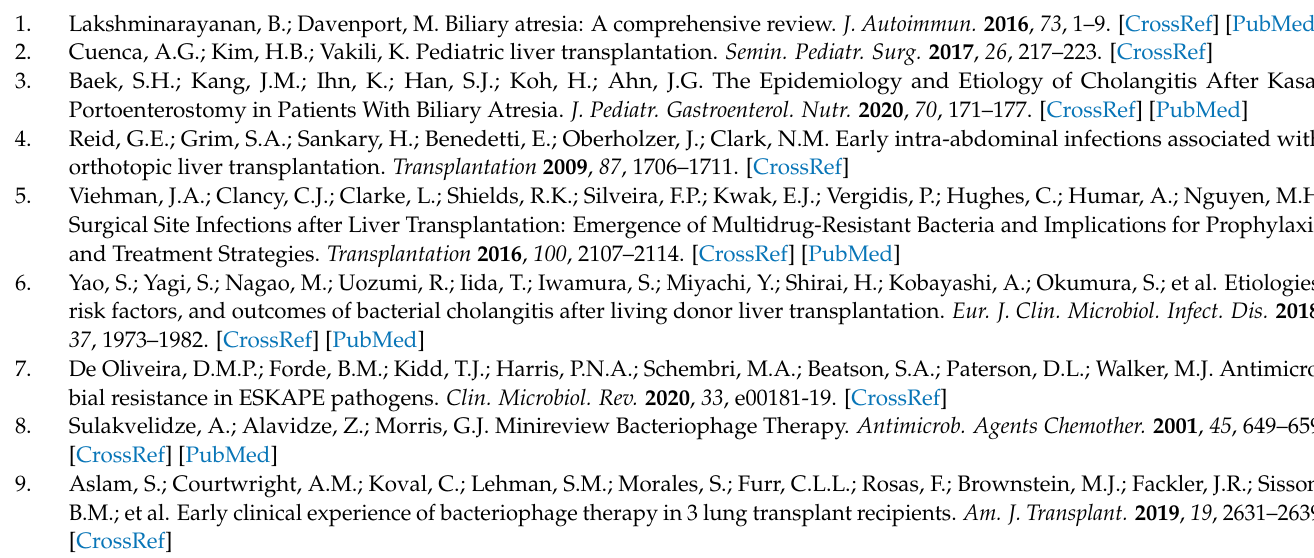
VRE fm ; Figure S2: Combined effect of phage EFGrKN and antibiotics on the target bacteria VRE fm ; Figure S3: Combined effect of phage EFGrNG and antibiotics on the target bacteria VRE fm